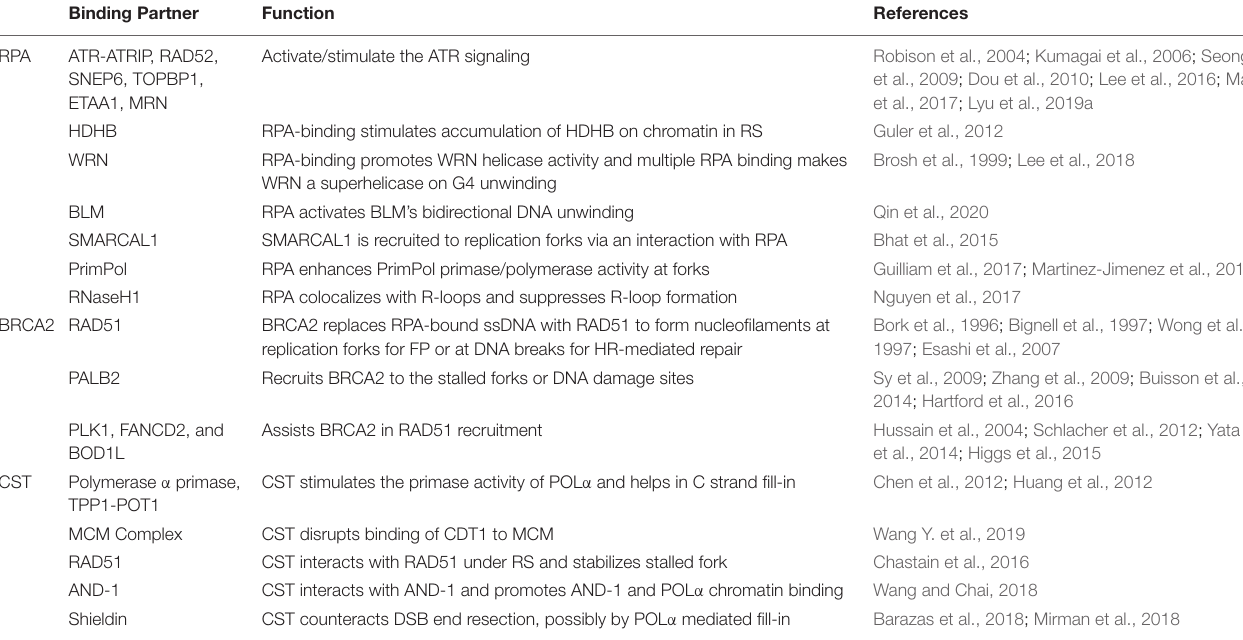
TABLE 1 | The binding partners of OB-fold proteins (RPA, BRCA2, and CST) and their roles in DNA replication process. Binding